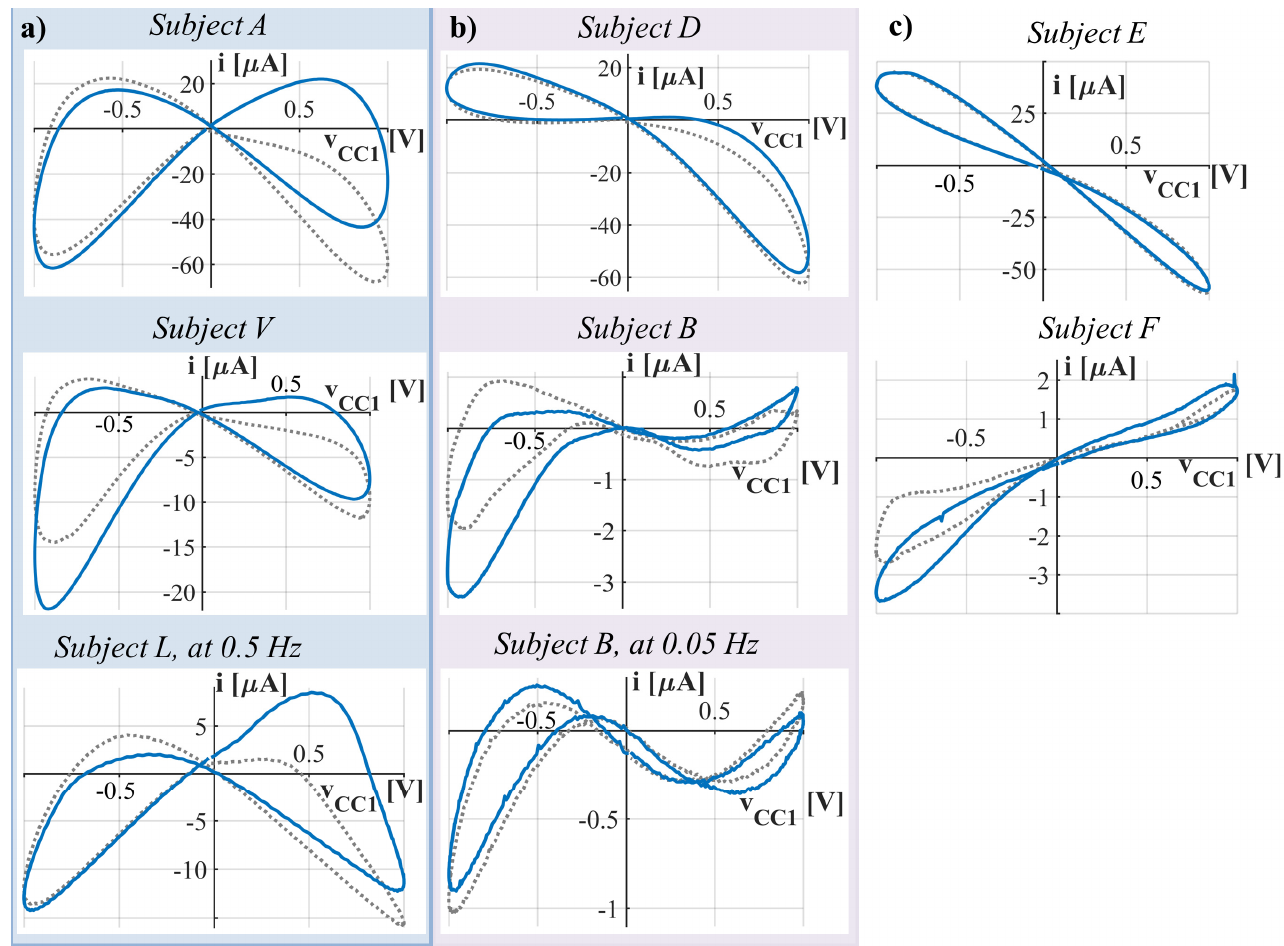
Fig. S2| Results from several subjects (voltage current plots) . These are the results of the two-memristor bridge circuit shown for the same subjects that are presented in Fig. 2. Here the measured current, i , is plotted over the applied sinusoidal voltage v CC1 (on CC1); the sign of the applied sinusoidal voltage v CC2 under CC2 was opposite. Even though pinched hysteresis loops may cross the second and fourth quadrant in this presentation (plotted with regard to v CC1 , but not v CC2 ) it does not mean that the corresponding memristor circuit is active. The plot of subject E, for example, just means that the skin under CC2 is dominating the measurement. The results are shown over two periods (the grey dotted plot presents the first period and the blue solid plot presents the second period). In the top and middle line, the results of the recordings with a voltage frequency of 0.005 Hz are shown. ( a ) Subject A, V at 0.005 Hz and Subject L at 0.5 Hz; all exhibited (more or less) full-wave rectified currents in Fig. 2. The corresponding V-I plots show pinched hysteresis loops with large lobe areas in the third and fourth quadrant but relative small areas in the first and second. ( b ) Subject D and B at 0.005 Hz and subject B at 0.05 Hz; all exhibited more or less half wave rectified currents in Fig. 2. The corresponding V-I plots show pinched hysteresis loops with relative large lobe area in either the third or fourth quadrant. Within the other quadrant (either fourth or third quadrant, respectively), the corresponding branch of the loop does not span a large area but is close to the x-axis instead. ( c ) Subject E and F. Since one skin site (under CC1 or CC2) dominates each measurement, the V-I plots reflect the pinched hysteresis loops of single skin